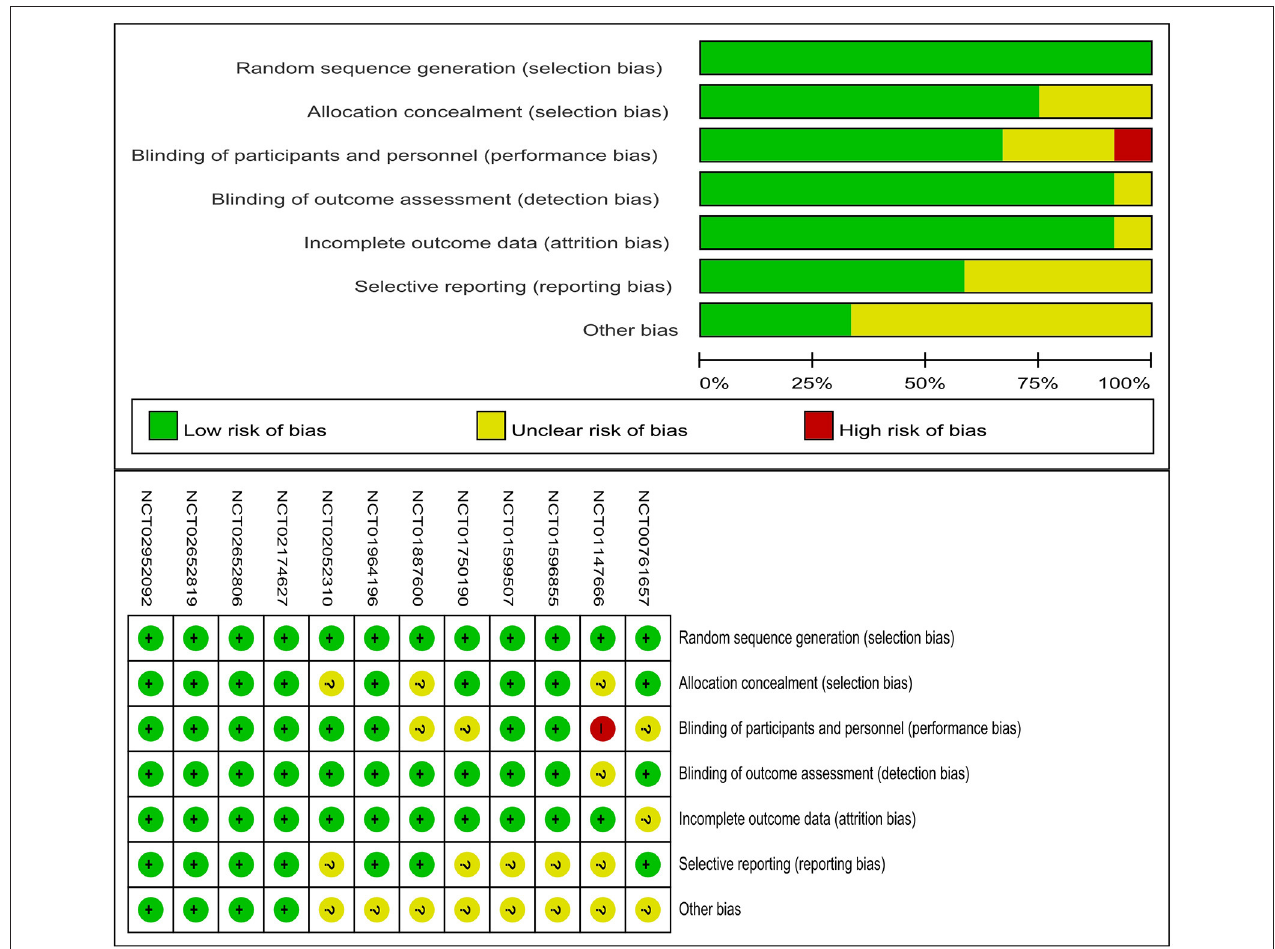
FIGURE 2 | Assessment of risk of bias. NCT, National Clinical